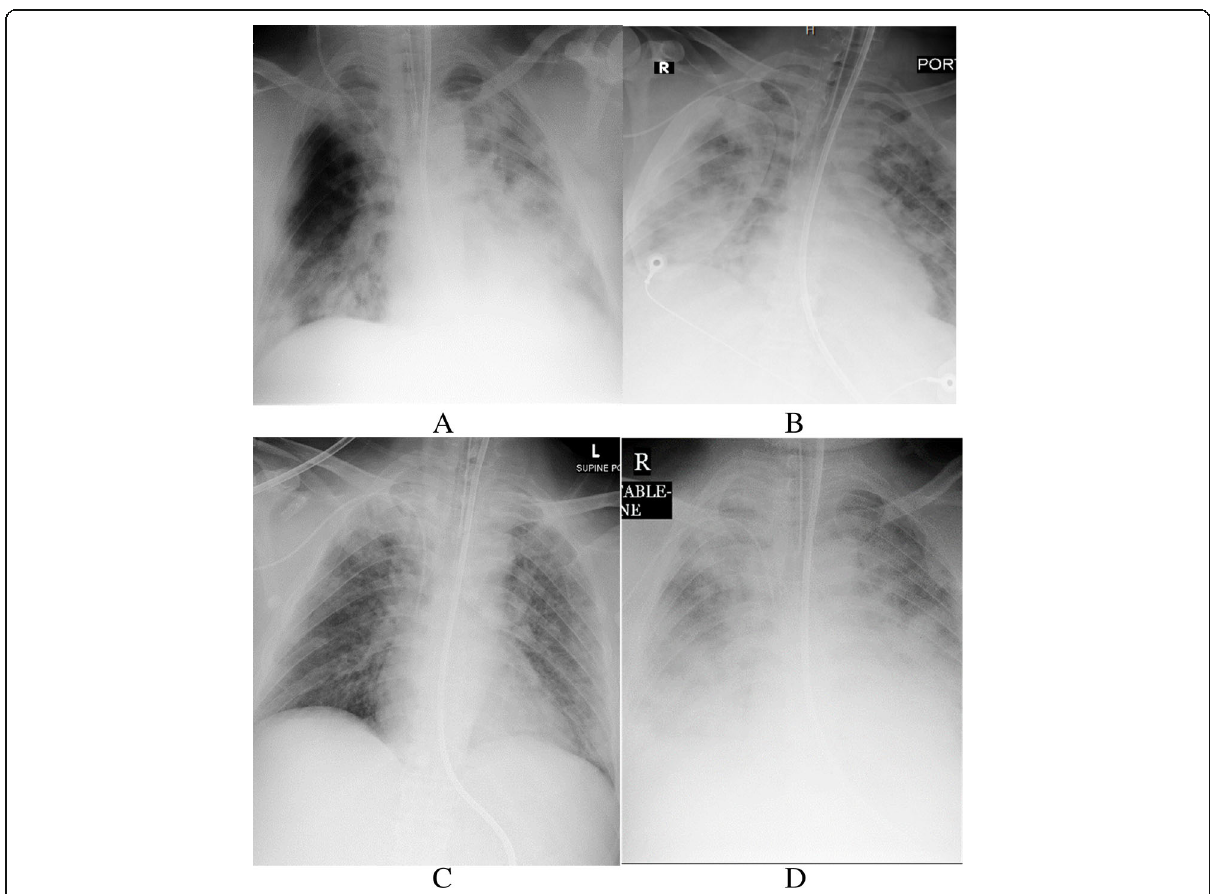
Fig. 2 A 68-year-old man with Middle East respiratory syndrome coronavirus. Serial chest radiographs show a type 3 pattern of progression. A A frontal chest radiograph shows ground-glass opacity in the right lower zone with consolidation areas in the left mid and lower zone with GGO in the left upper zone. B On day 6, a follow-up frontal chest radiograph shows a marginal improvement of the left lung opacity with an increase of GGO in the right side. C A follow-up frontal chest radiograph on day 9 shows a considerable improvement of both lung opacities. D A follow-up frontal chest radiograph on day 12 shows a considerable improvement of both lung opacities. The patient died on the 13th